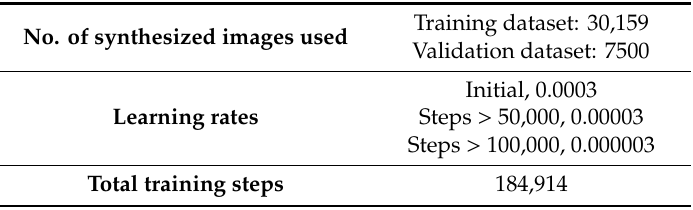
Table 5. Summary of deep learning setup.